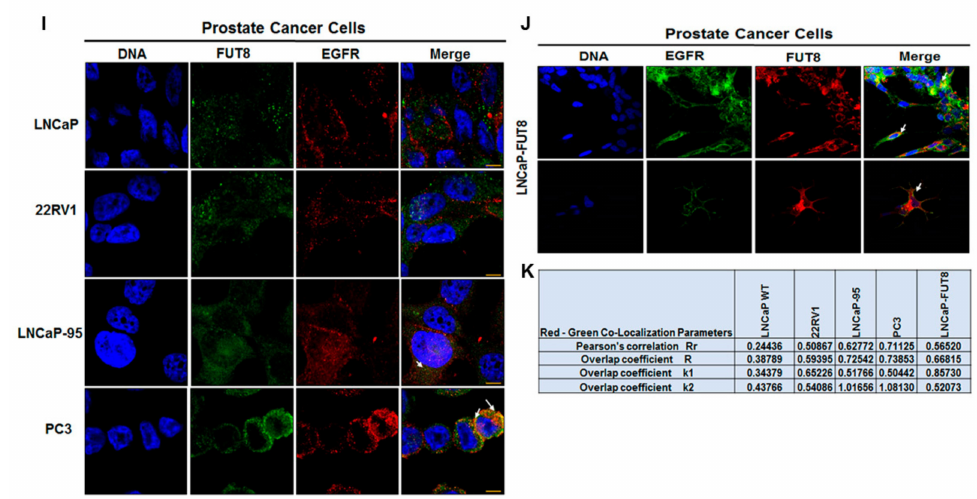
Figure 2. E ff ects of FUT8 expression on global and cell surface receptors. Heat map from the globally identified proteins (log2 fold change) ( A ) and the cell surface receptors ( B ) that were di ff erentially expressed between prostate cancer cells (LNCaP-FUT8, LNCaP-95, and PC3) compared to the wildtype LNCaP-Ctr cells ( A , B ). Using a cuto ff of 1.5-fold change between phosphorylated proteins in LNCaP-FUT8 / LNCaP Ctr, were subjected to ingenuity pathway analysis which demonstrate the activation of epidermal growth factor receptor (EGFR) signaling pathway ( C ). Western Blot analysis for the total and phospo-p38 MAPK kinases protein ( D ). Ratios of the phosphorylated peptides for all the cell surface receptors identified in the phosphoproteomics data were plotted as a heat map to show the di ff erential expression of phosphorylated cell surface receptors ( E ) and intact glycosylated peptides ( F ). Fold changes between the intact glycopeptides for EGFR ( G ) and the di ff erentially expressed fucosylated glycoforms for the EGFR ( H ) identified across the cell lines. Confocal microscopy to evaluate the localization for the EGFR and FUT8 in LNCaP-WT, 22RV1, LNCaP-95, PC3, and LNCaP-FUT8 cells. White arrows indicate colocalization of the FUT8 and EGFR proteins. ( I , J ). Quantitation and Pearson’s correlation for the colocalization of the red and green signals between the cell lines ( K